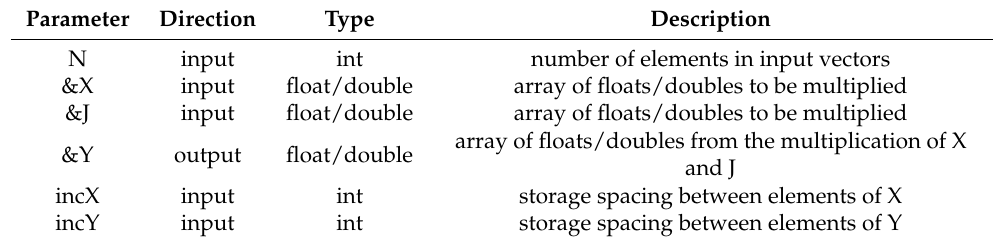
Table 5. Input and output parameters for kernel vmul .